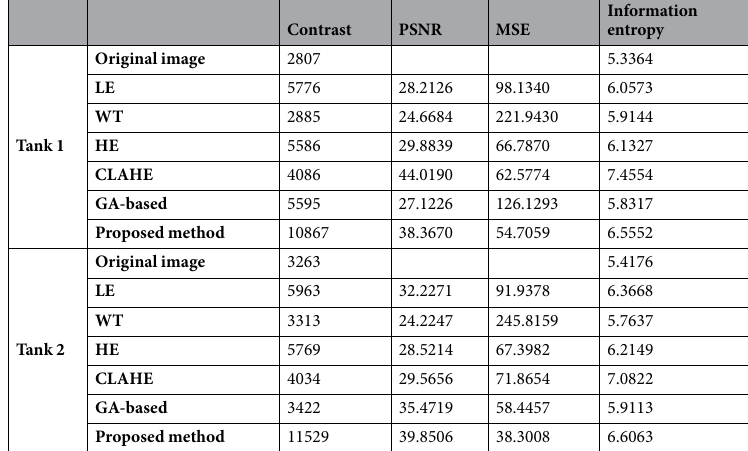
Table 2. Quality Evaluation Index.